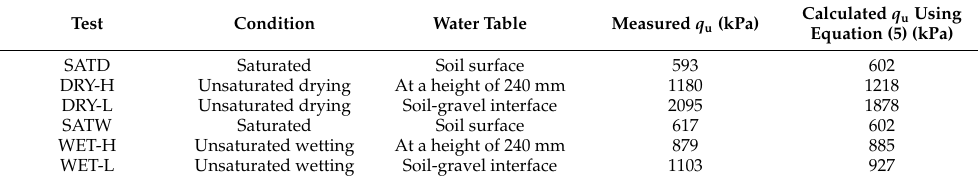
Table 2. Index properties of the unsaturated samples at multiple depths.